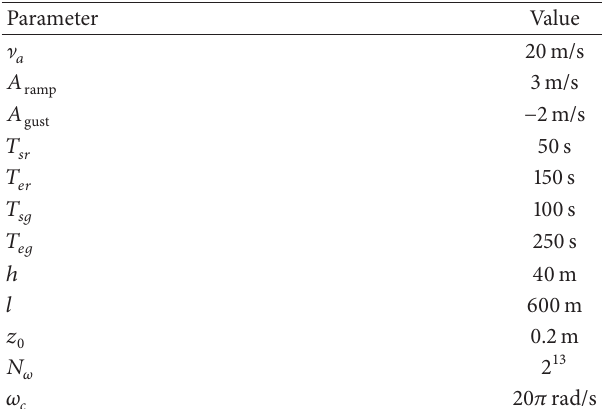
Table 3: Wind speed model